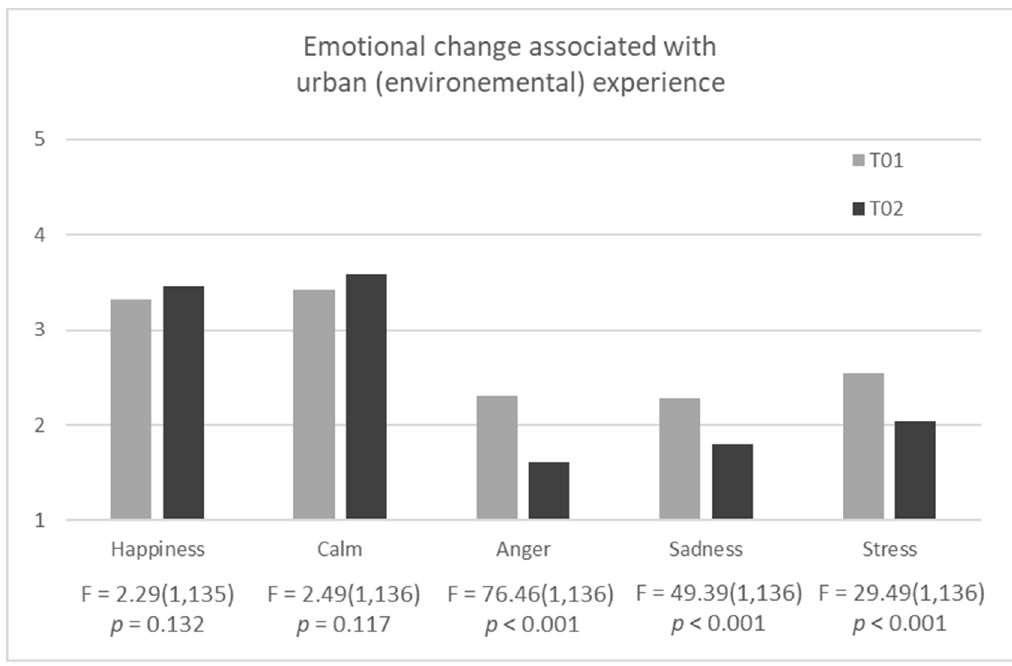
Figure 3. Effect of the urban experience on the four basic emotions and perceived stress, before (T01) and after (T02) renovation of the urban places (ANOVA test).